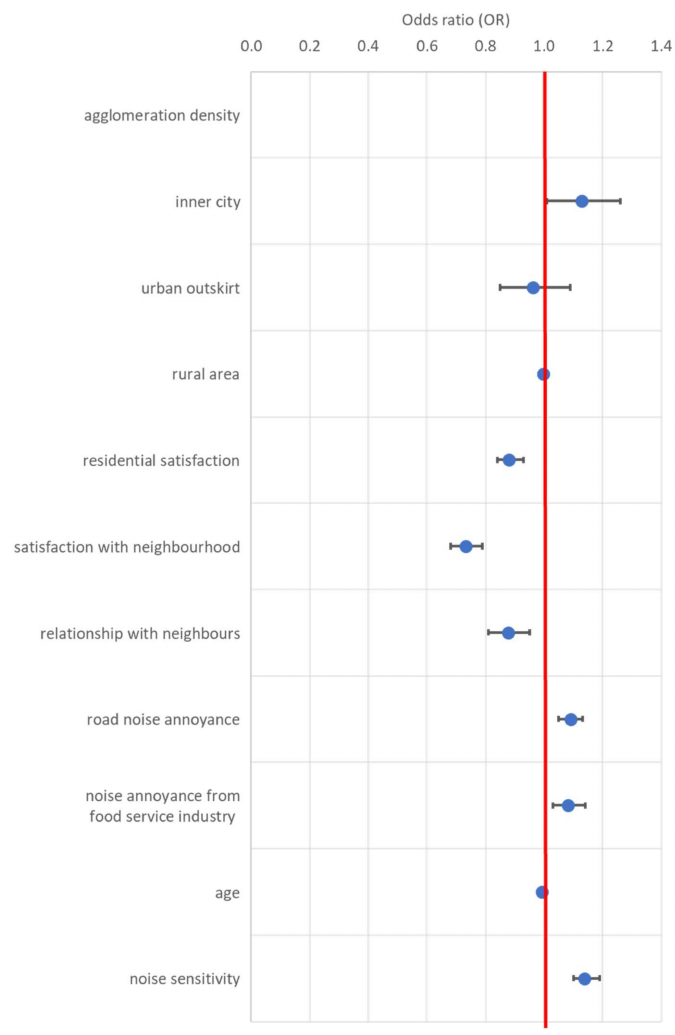
Figure 1. Odds ratios (OR) of the predictors to neighbour noise annoyance derived from the GZLM regression